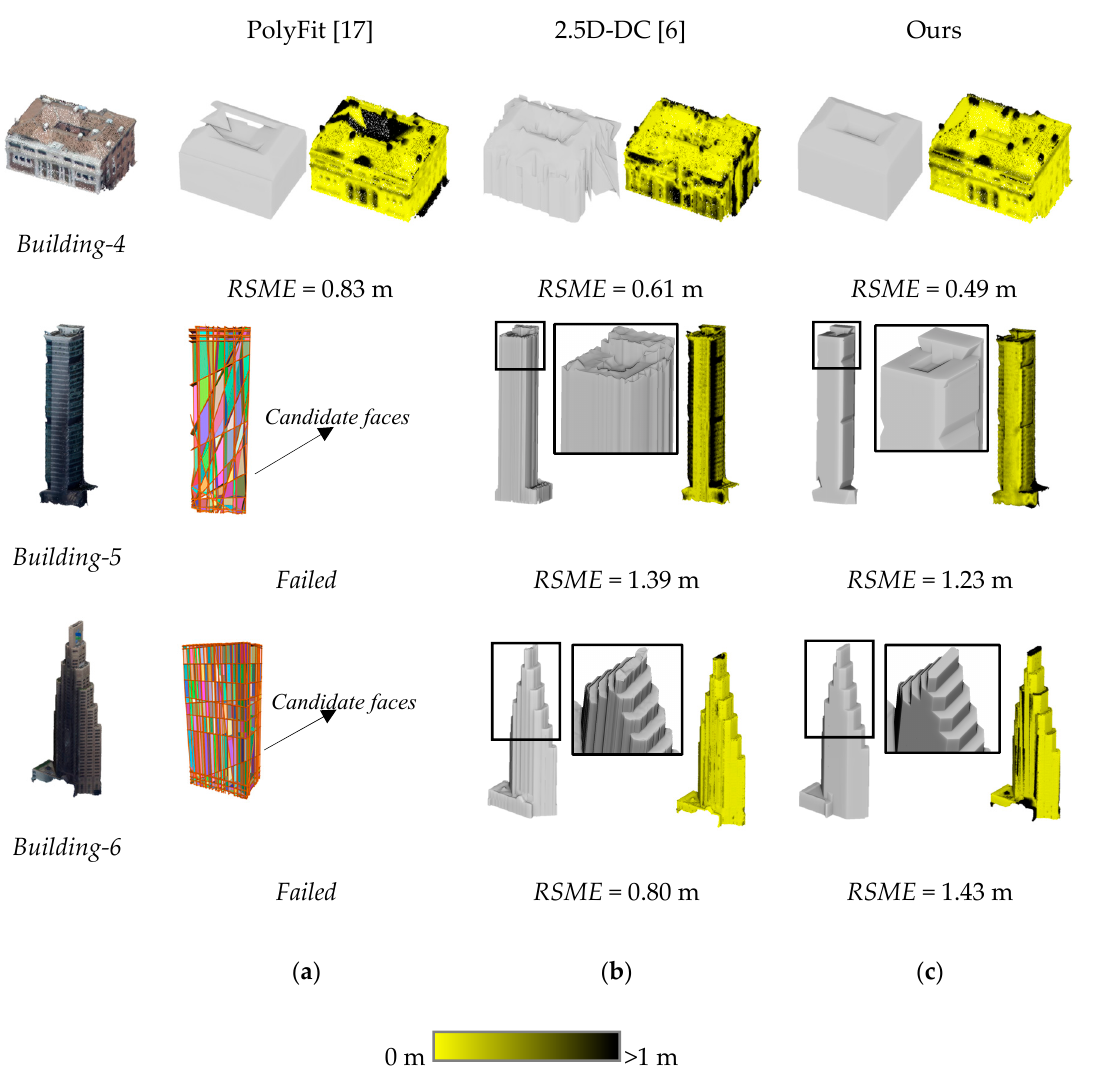
Figure 19. Evaluations of the reconstruction results of three complex buildings using our method, and comparison with the results of PolyFit [17] and 2.5D-DC [6]. ( a ) Results of PolyFit; ( b ) Results of 2.5D-DC; ( c ) Results of our method.